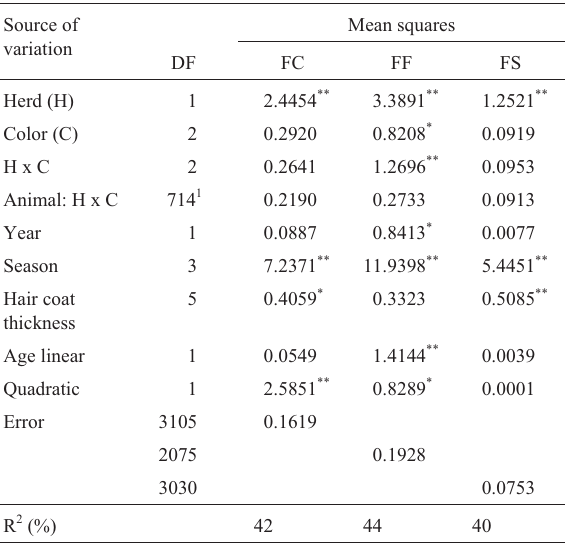
Table 2 - Summary of the analyses of variance of number of flies counted on animals (FC), number of flies in photographs (FF), and of infestation score (FS).